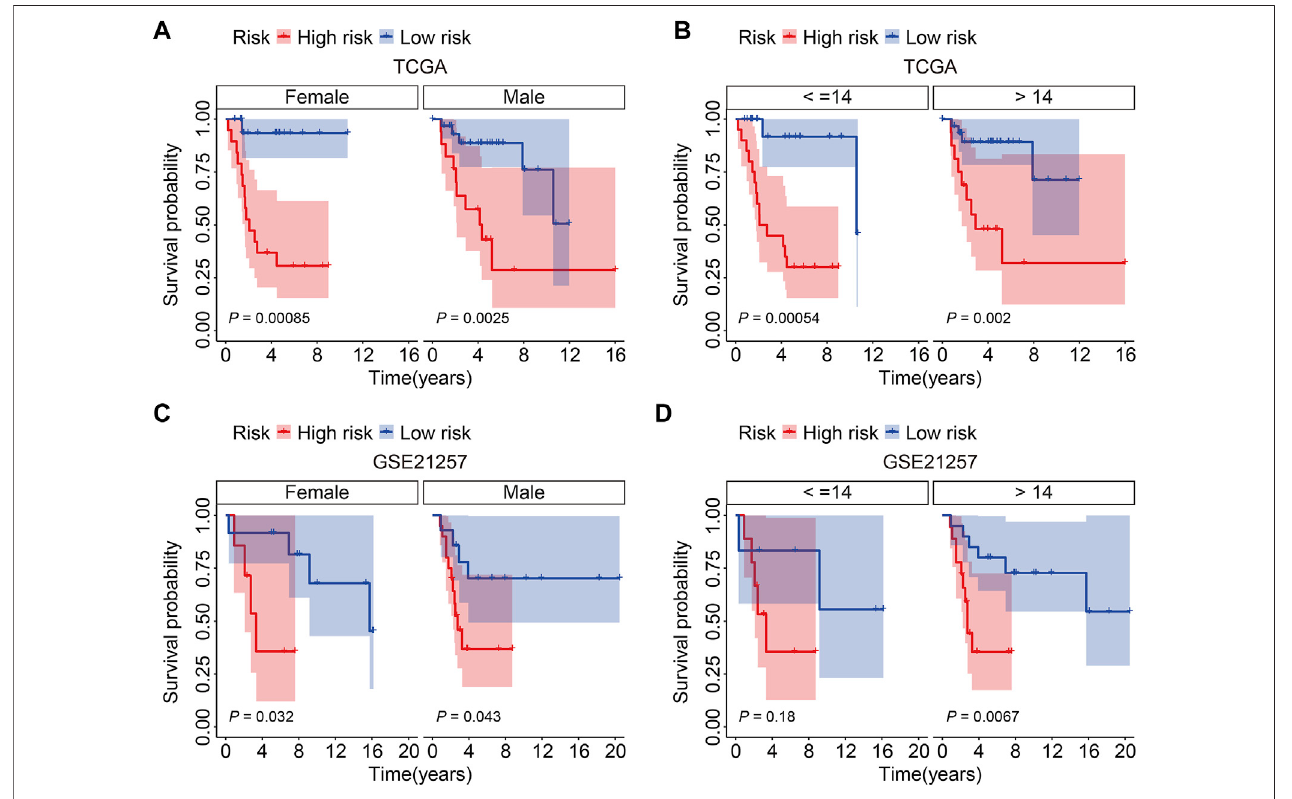
FIGURE 5 | Kaplan-Meier survival analysis in subgroups classi fi ed by gender (female, male) or age ( ≤ 14, > 14) in TCGA cohort (A,B) and GSE21257 cohort (C,D) .